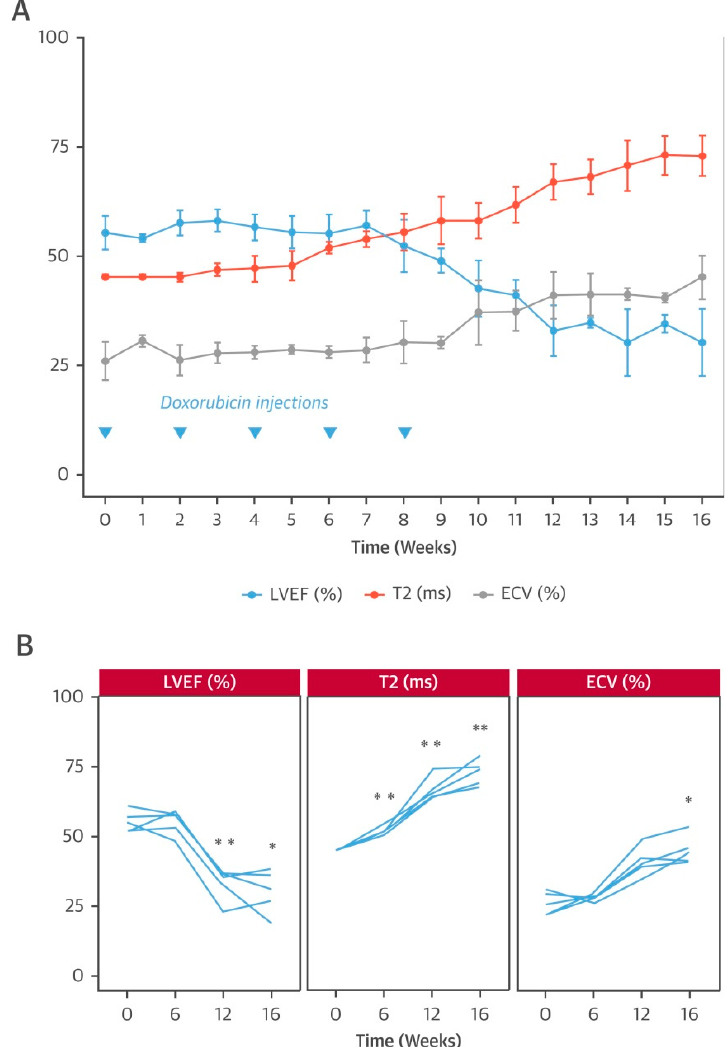
Figure 3. Animal model of anthracycline cardiotoxicity. ( A ) Time course of CMR imaging studies in pig model that received 5 biweekly doxorubicin injections and follow-up to week 16. Data are represented as mean ± SD (bars); ( B ) Individual animal data at selected time points for LVEF, T2, and ECV. Asterisks indicate statistically significant differences compared with week 0: * p < 0.05, ** p < 0.01. Reprinted with permission from Ref. [40]. 2019, Elsevier.